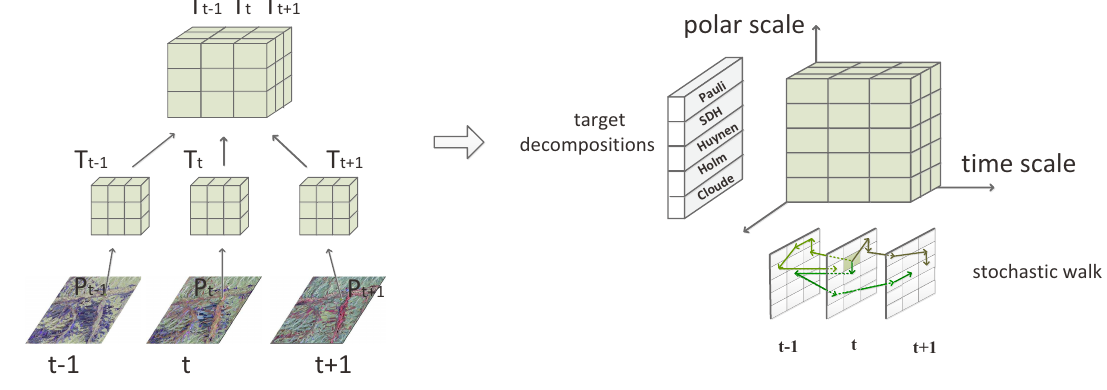
Figure 2. A 3-D descriptive primitive of a single